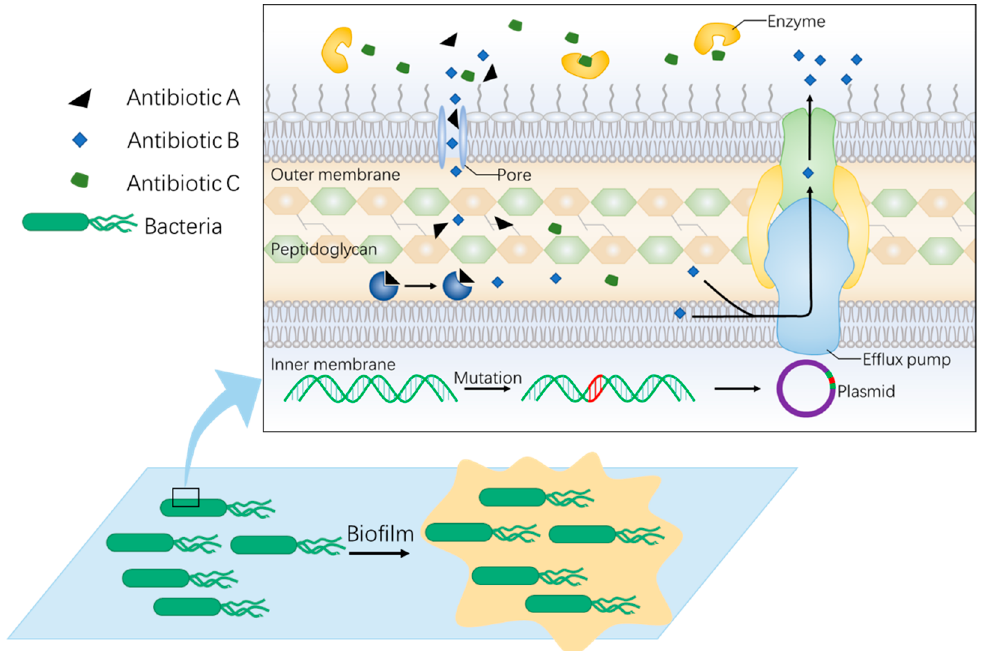
Figure 1. Mechanisms of bacterial resistance. The figure shows a brief overview of intrinsic re- sistance mechanisms. Firstly, bacteria acquire drug-resistance through gene mutation at the genetic level. The mutated gene can also spread through vertical and horizontal transmission (herein, plasmid for example). Besides, biochemical mechanisms are a more common style of antidrug upon target change, efflux or inactivation. Moreover, the formation of biofilm prevents bacteria from reaching the antibiotic and enhances drug resistance.